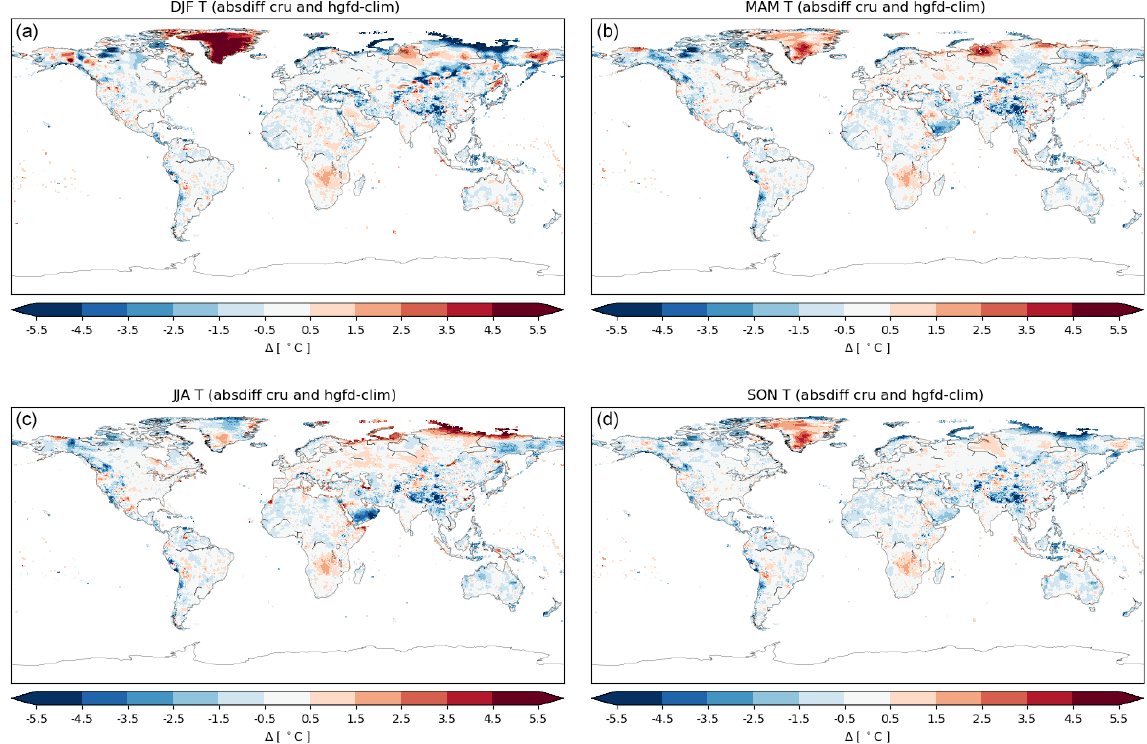
Figure 6. Absolute-difference T climatology for the period 1980–2009 between cru and HydroGFD3 for each season: (a) December– February, (b) March–May, (c) June–August, and (d)